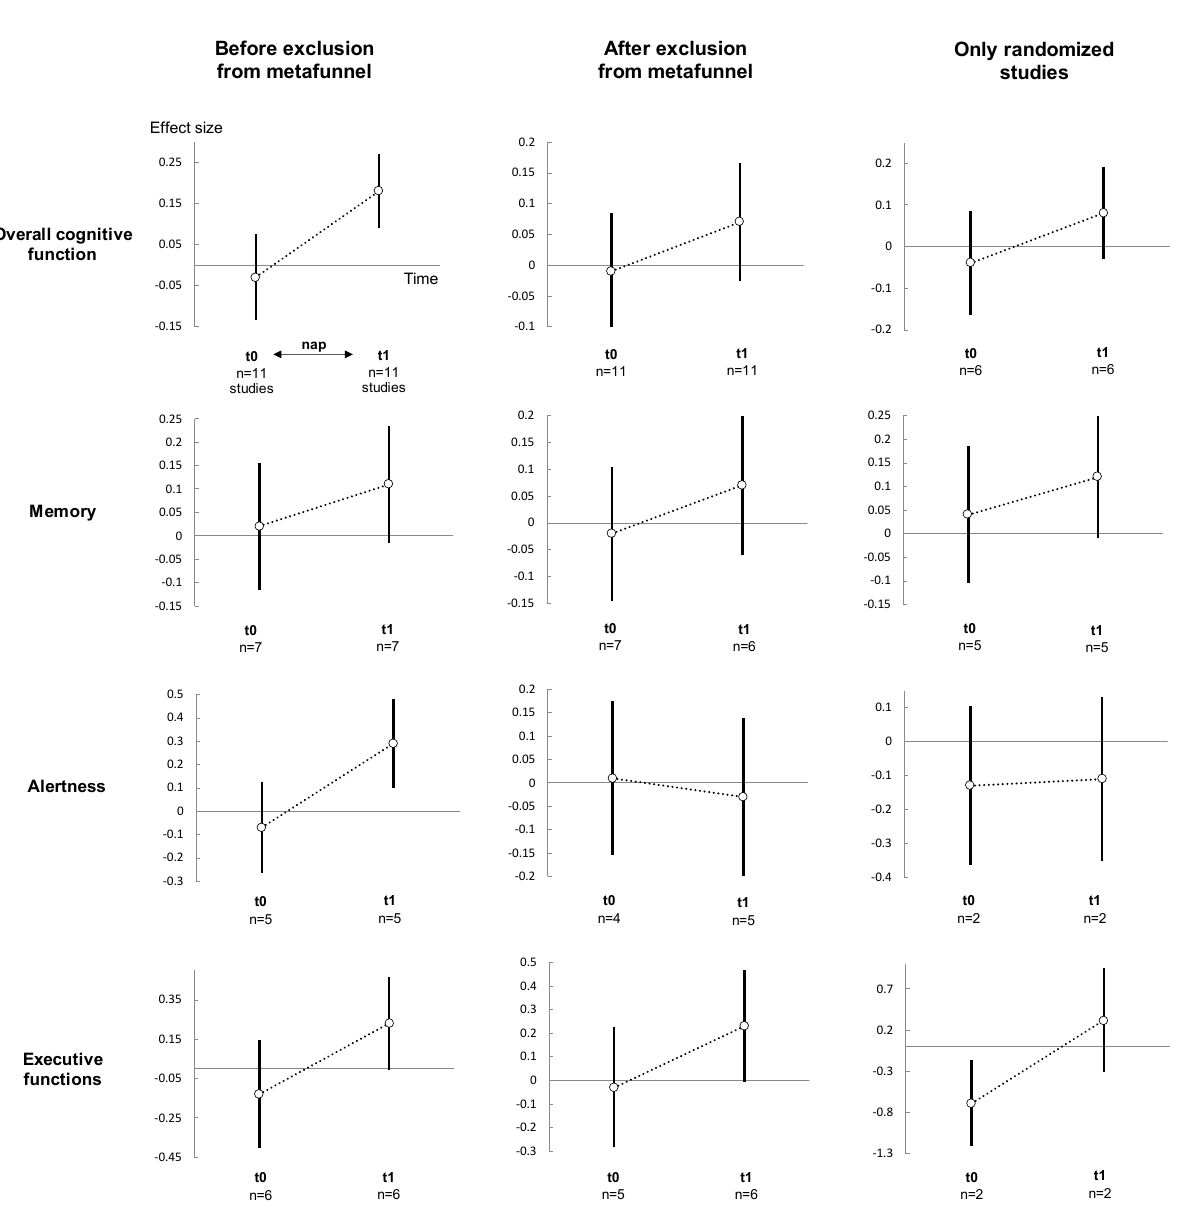
Figure 3. Summary of meta-analysis on cognitive performance between groups (nap vs. control), for each cognitive function: before ( left ), after ( middle ) exclusion of studies not evenly distributed around the funnel plot and ( right ) non-randomised controlled trials. For details of the meta-analysis at each analysis time, please see Figure S3 for meta-analyses t1. For details of the meta-analysis on each cognitive function, please see Figure S1 for meta-analyses at t0, and Figure 4 for t1. For details of the meta-analysis on each group, please see Figures 4 and S4 for the nap group, Figure 5 for the control group. t0: baseline; t1: after intervention (nap or no-nap). Each overall summary of a meta-analysis is represented in the graph by a dot on a vertical line. The black dots represent the overall pooled-effect estimate of individual meta-analyses (pooled effect size—ES), and the length of each vertical line around the dots represents their 95% confidence interval (95CI). Shorter lines represent a narrower 95CI thus higher precision around pooled-ES. Conversely, longer lines represent a wider 95CI and less precision around pooled-ES. The black solid horizontal line represents the null estimate (with a value of 0 for pooled-ES). Vertical lines that cross the null horizontal line represent a non-significant overall summary of the meta-analysis at each time analysed (t0 and t1).